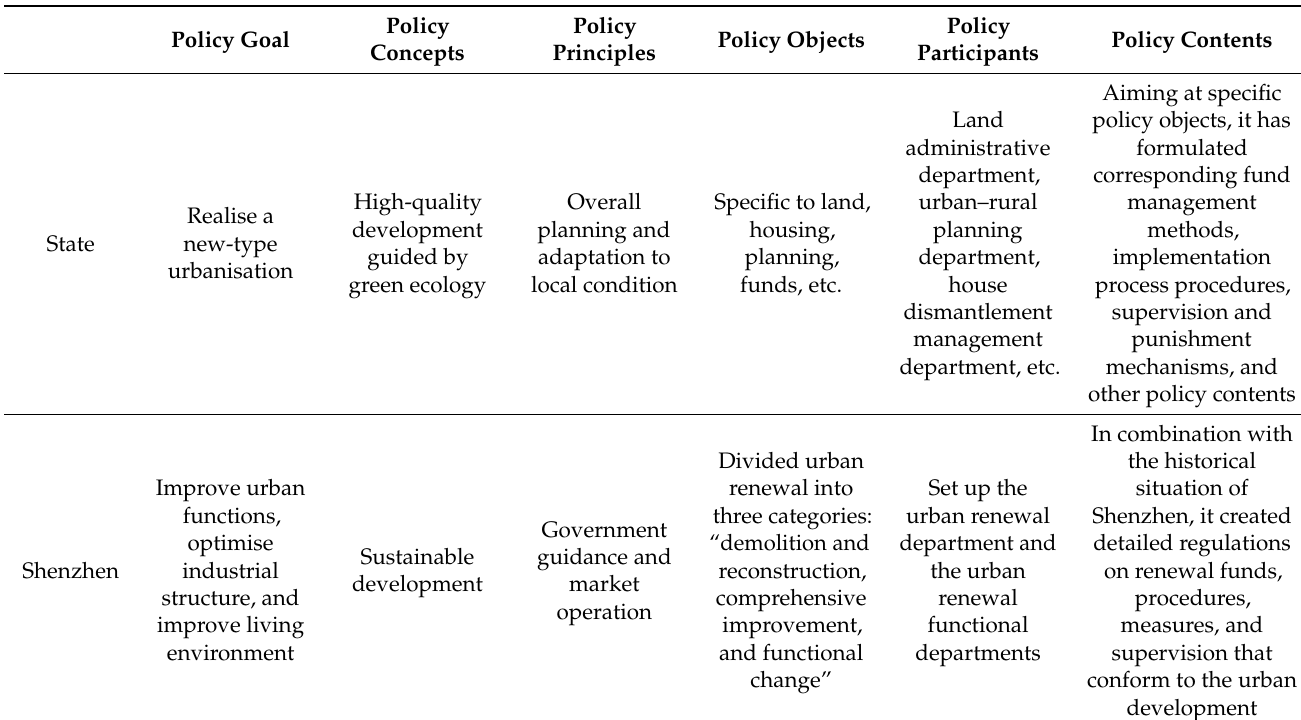
Table 10. The transfer correspondence between the State policy and Shenzhen